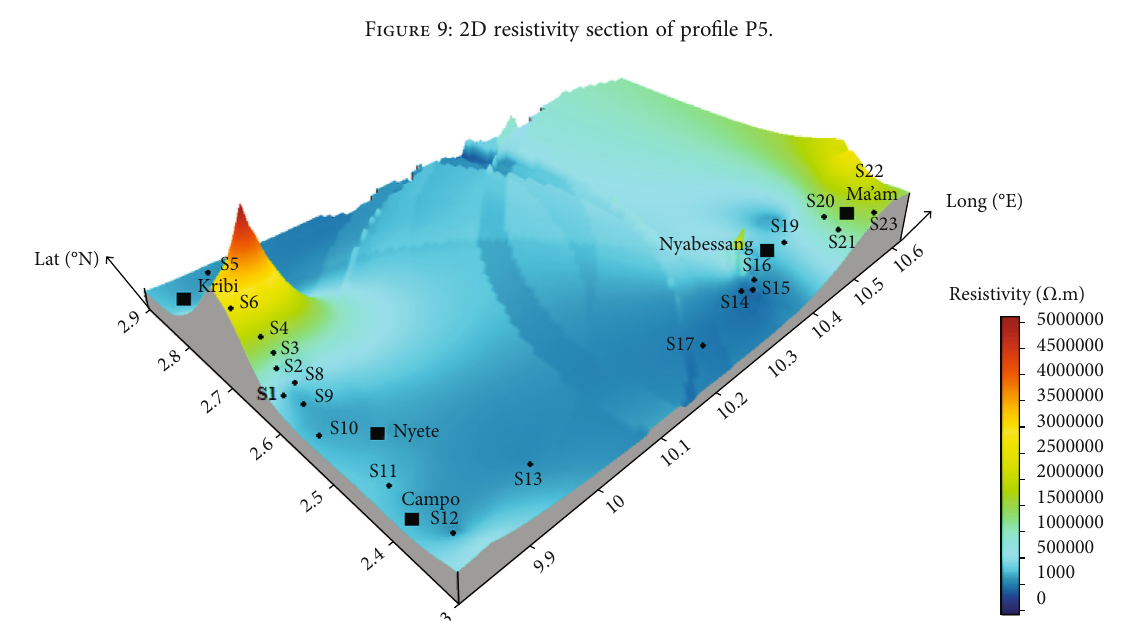
Figure 10: 3D model of the resistivity fi